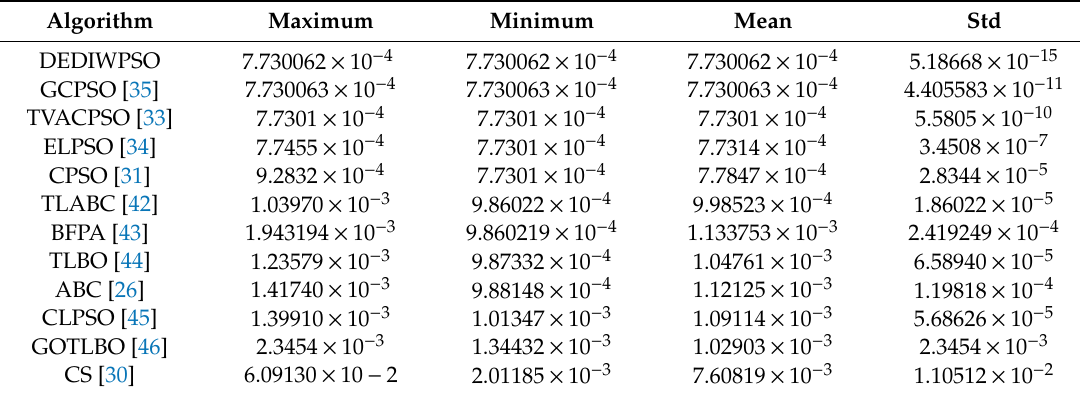
Table 2. Comparsion of the obtained RMSE for the single-diode cell.